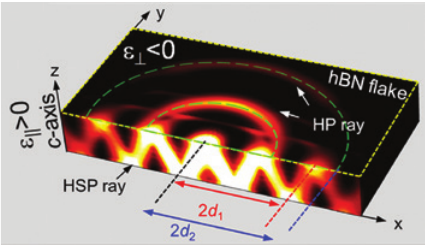
Figure 19: Two types of confined modes at an hBN flake with = ε < 0 and ε > ε x y z